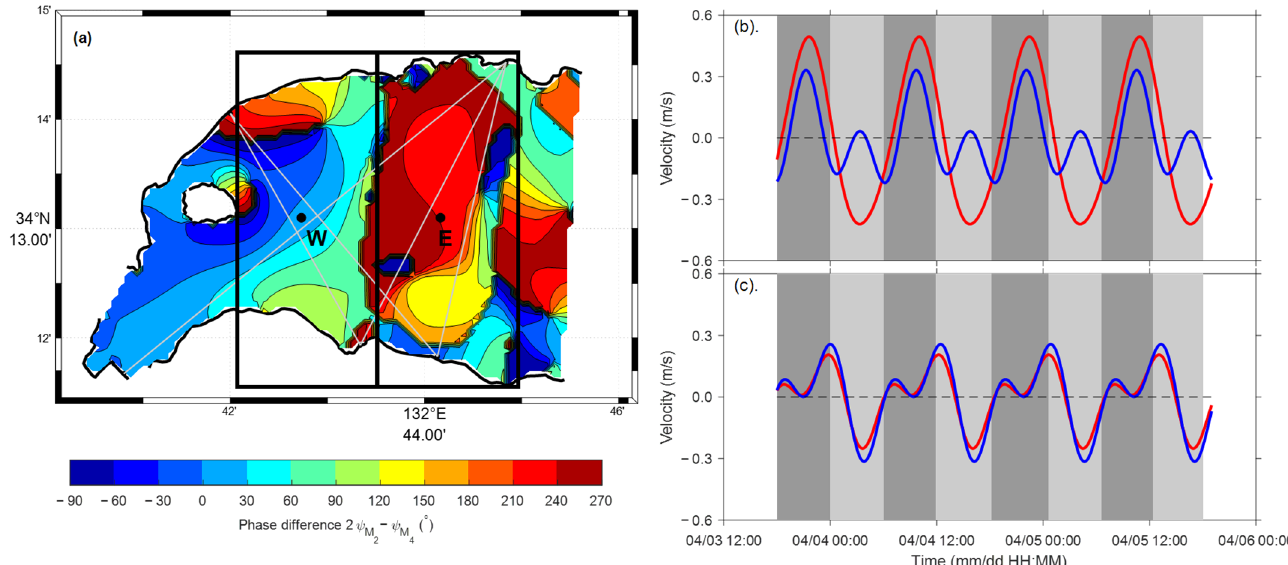
ϕ ϕ− 2 − ϕ . ( b , c ) Time plots of the east–west (red M 4 . ( b , c ) Time plots of the east–west (red M M 2 2 4